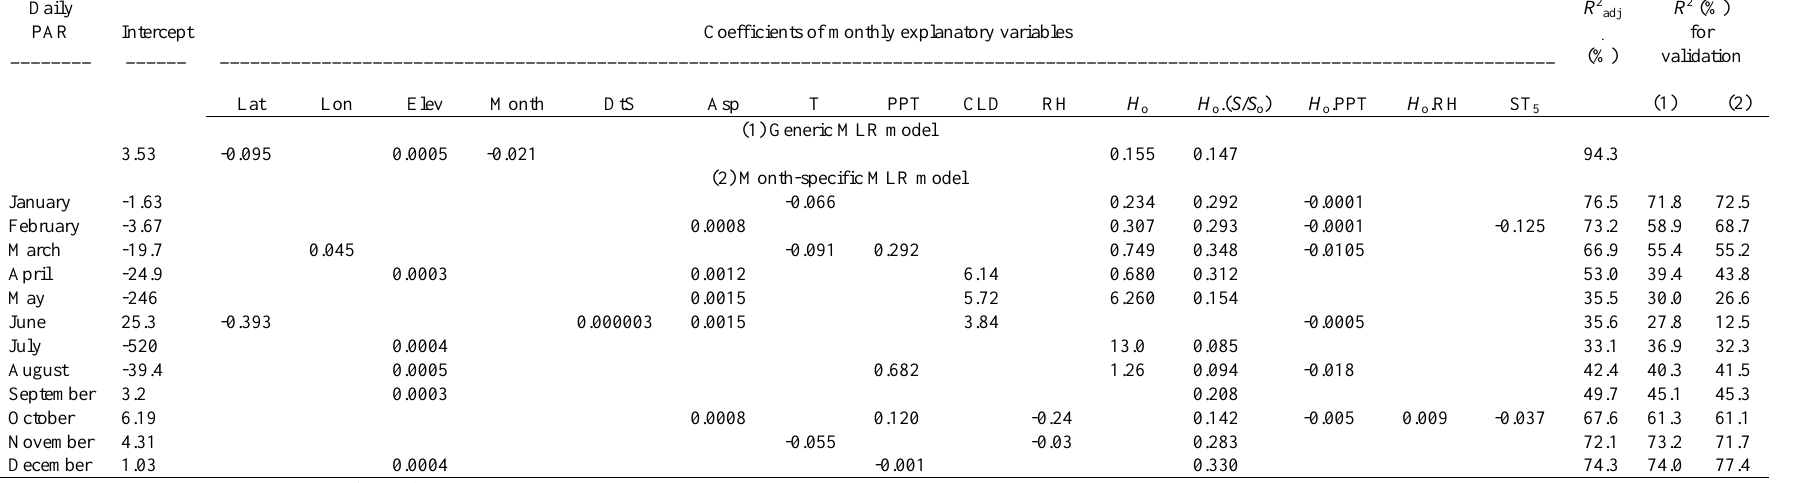
Table 3. Generic and month-specific multiple linear regression (MLR) models of monthly mean daily incident photosynthetically active radiation (PAR, MJ m -2 day -1 ) derived from 125 climate stations and their validation against an independent dataset of 35 climate stations across